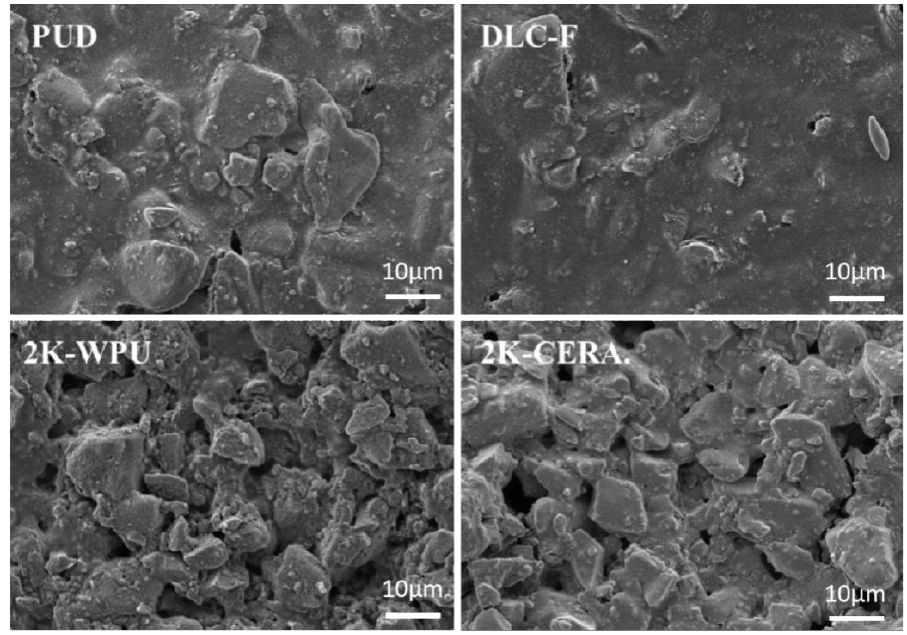
Figure 5. SEM of PUD, DLC-F, 2K-WPU, and 2K-CERA. film. The scale bar represents 10 µm.